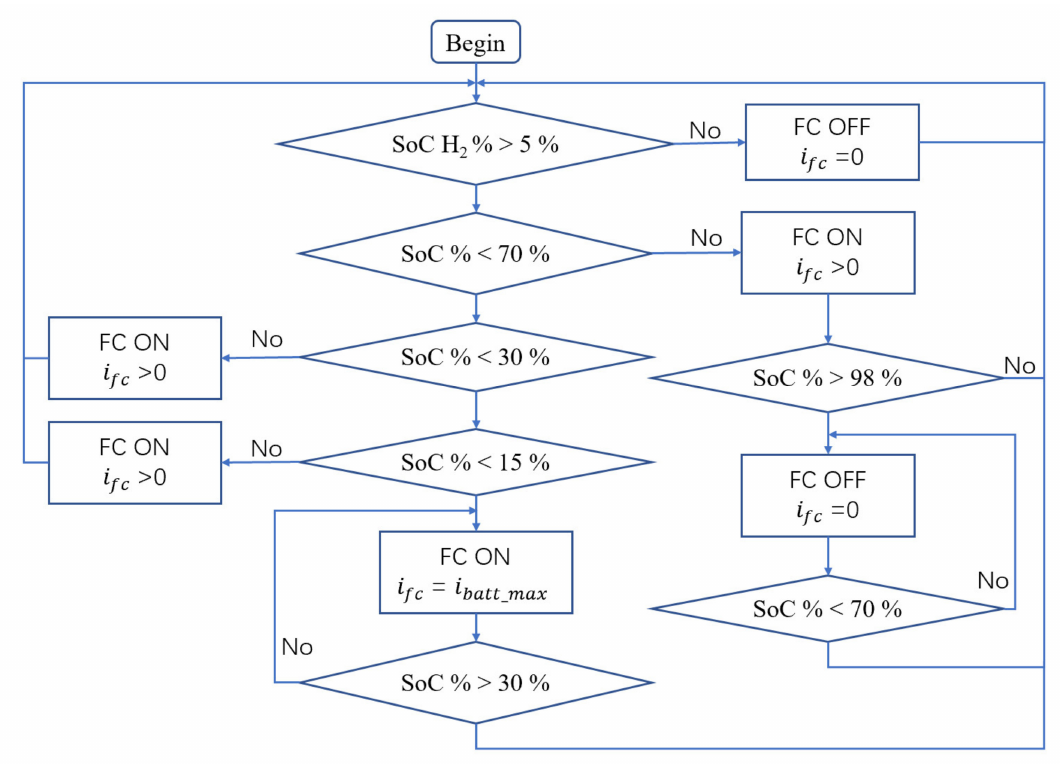
Figure 16. Flow chart of an energy distribution